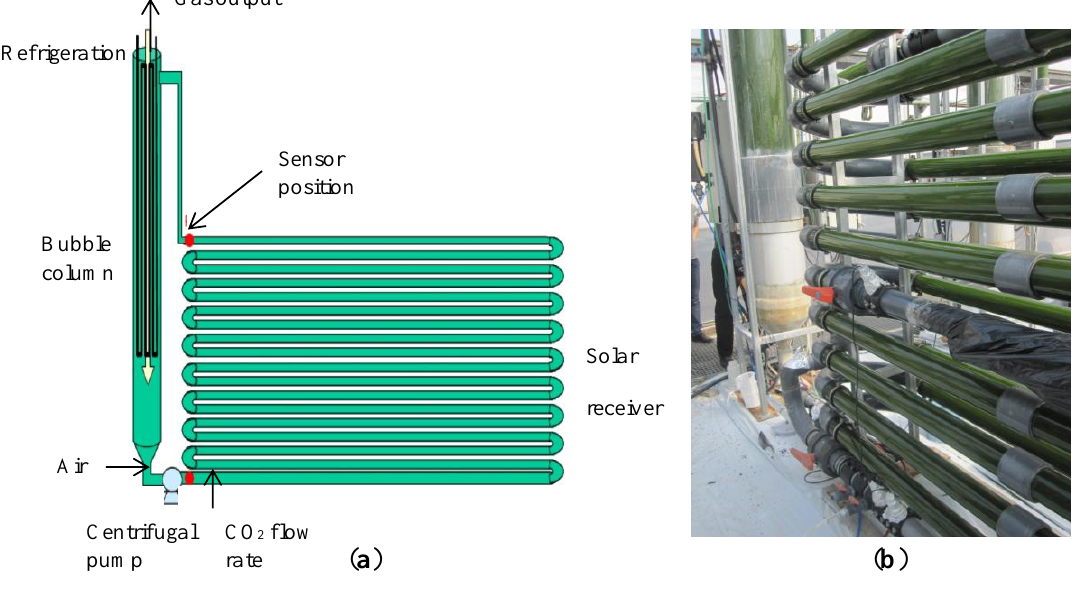
Figure 3. ( a ) Schema of the process. ( b ) Partial view of the mixing unit and the tubular loop of the PBR located in Almería